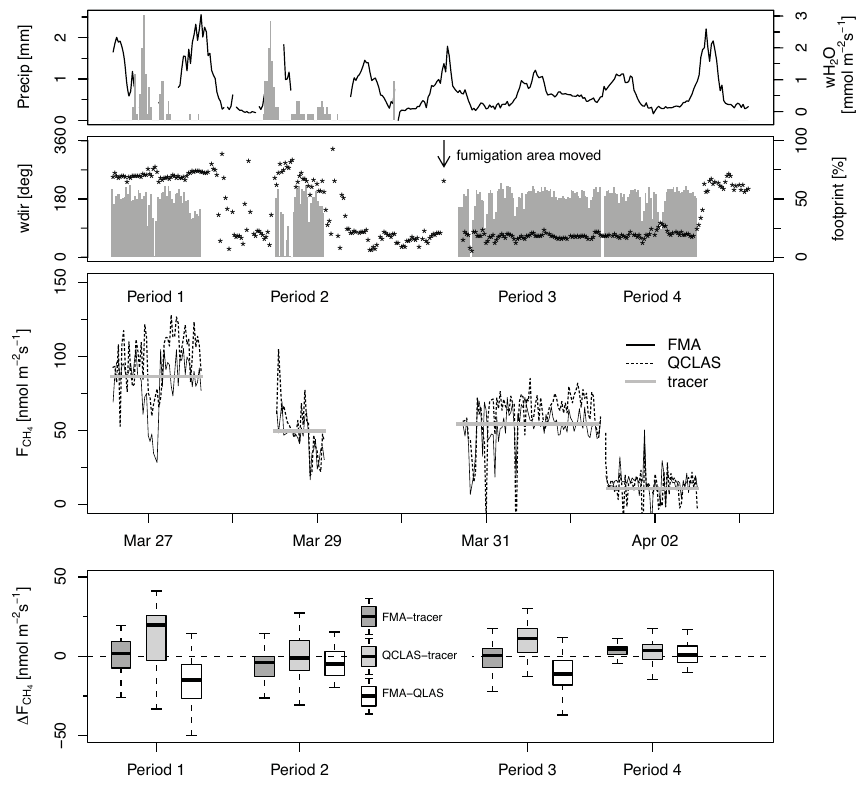
Fig. 7. Methane fluxes during the fumigation experiment. The top panel shows precipitation and the water vapour flux. Wind direction and the proportion contributed by the fumigated area to the measured flux are displayed in the second panel. In the third panel, the footprint corrected fluxes are plotted for the fumigation periods. The gray solid line represents the applied flux. Additionally, the boxplot illustrates the difference of the measured and the applied flux for each system as well as the difference between the two instruments for each fumigation period. The upper and lower ends of the box are drawn at the quartiles, and the bar through the box at the median. The whiskers extend from the quartiles ± 1.5 the inter quartile